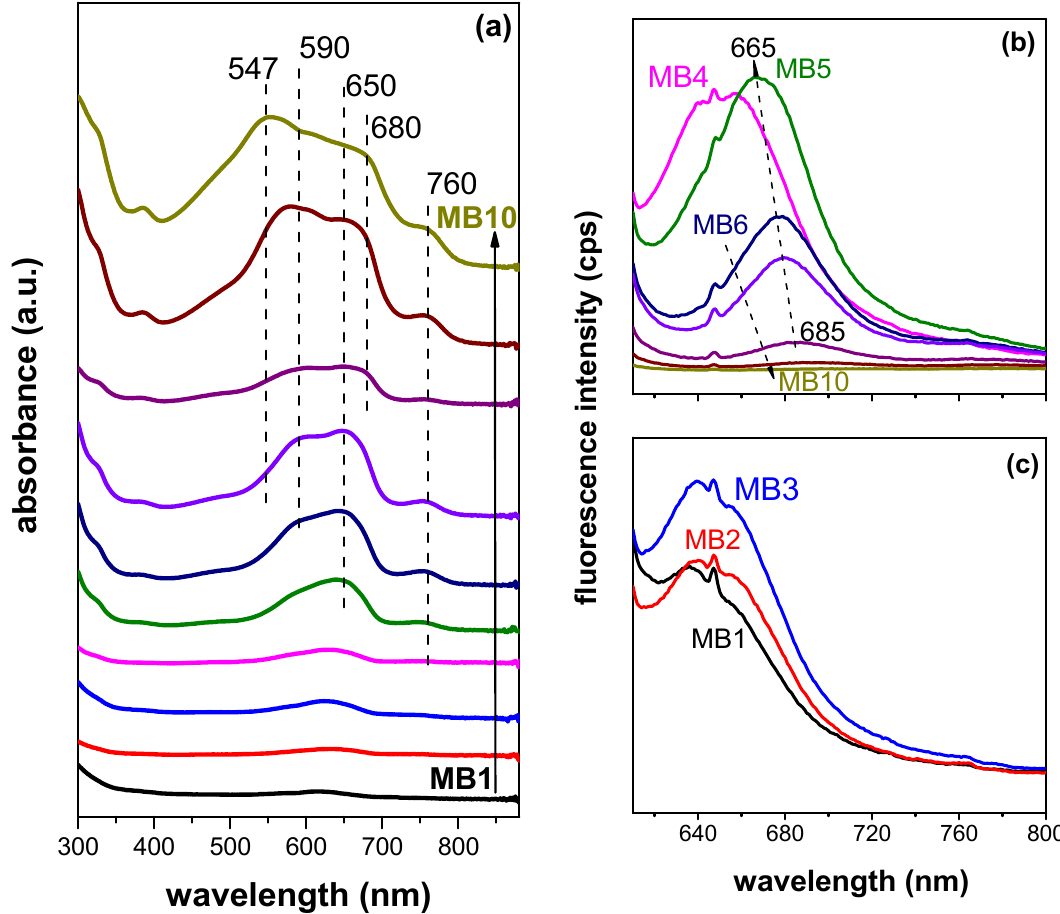
Figure 6. UV-Vis absorption ( a ) and fluorescence spectra ( b , c ) of composite films functionalized with methylene blue. The scales of Figure 6b,c are the same.